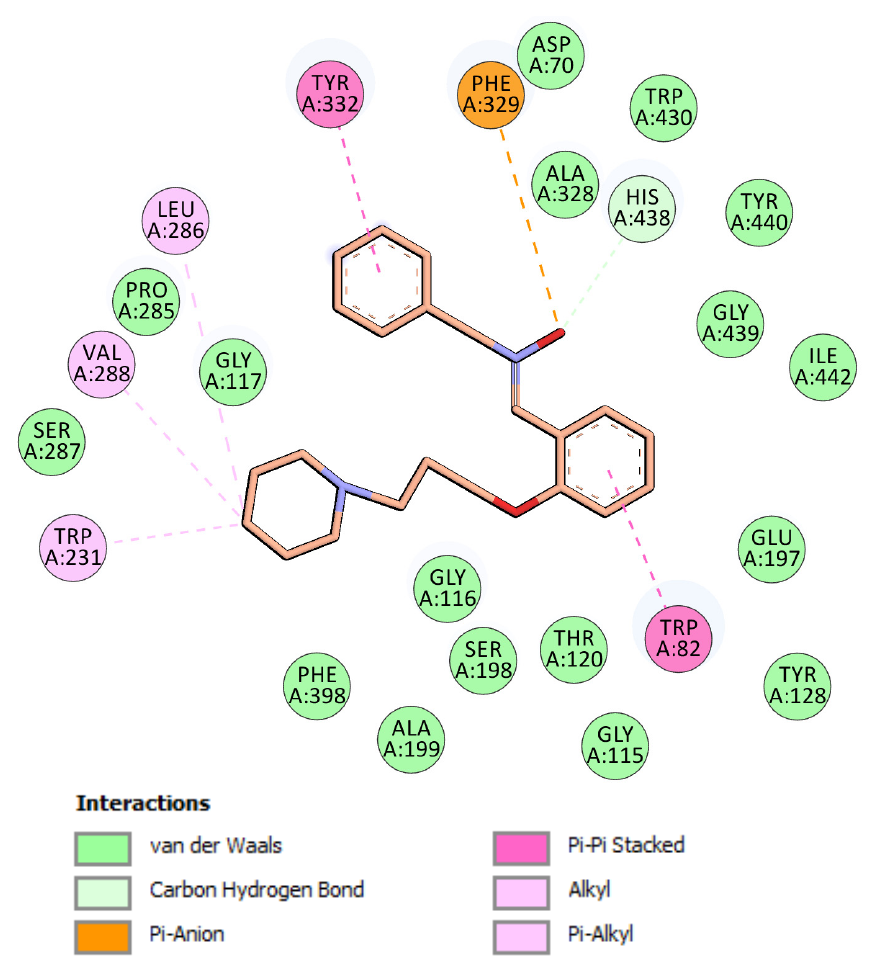
Figure 4. Schematic 2D representation of hBChE binding site amino acids interacting with nitrone 5 . Binding mode